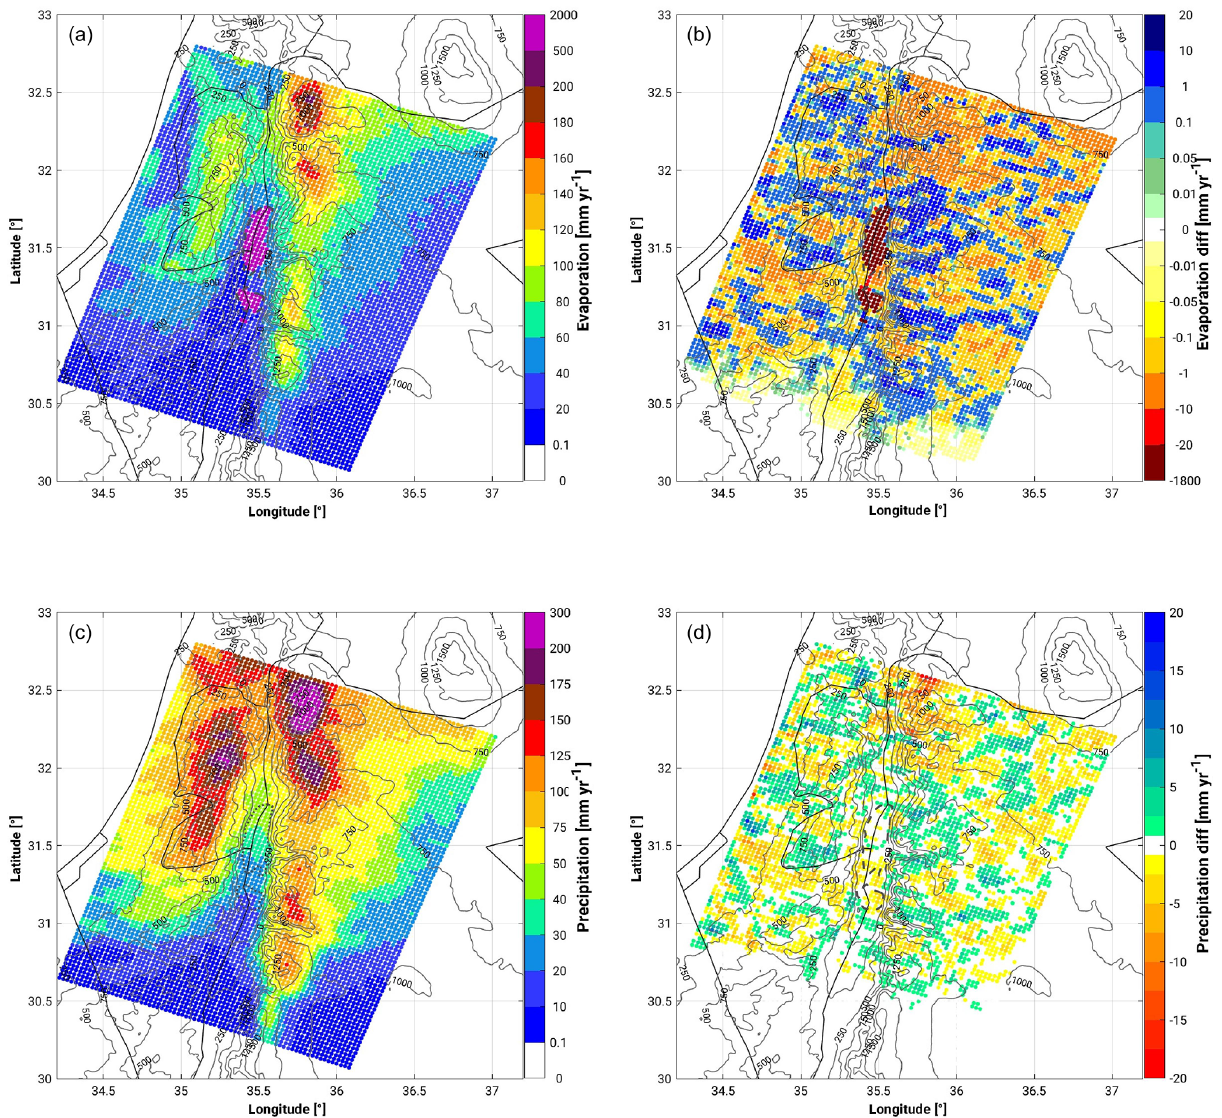
Figure 5. Spatial distribution of (a, b) evaporation in the REF CLIM simulation (a) and the difference between the SEN CLIM and the REF CLIM simulations (b) and (c, d) precipitation in the REF CLIM simulation (c) and the difference between the SEN CLIM and the REF CLIM simula- tions (d) . The period 2004 to 2013 is